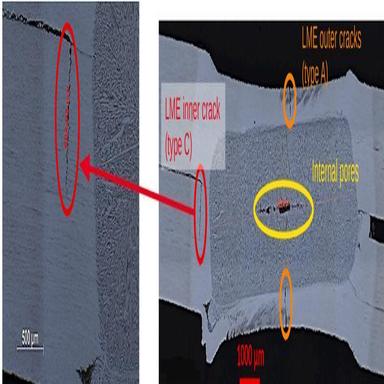
Metallographic cross section.